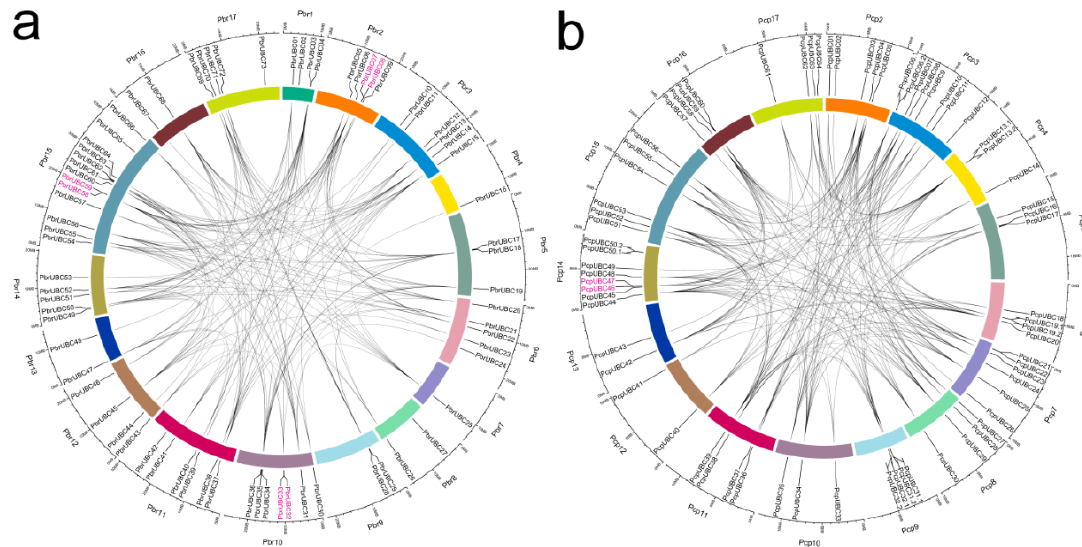
Figure 3. Localization and duplication of UBC genes in the P. bretschneideri ( a ) and P. communis ( b ) genome, respectively. The localizations of PbrUBCs and PcpUBCs mapped on the P. bretschneideri and P. communis genome, respectively, were obtained from Circos software [40]. The P. communis and P. bretschneideri chromosomes are labeled Pcp and Pbr, and are represented by different color boxes, respectively. Red regions indicate tandem duplication, and grey lines represent segment duplication.